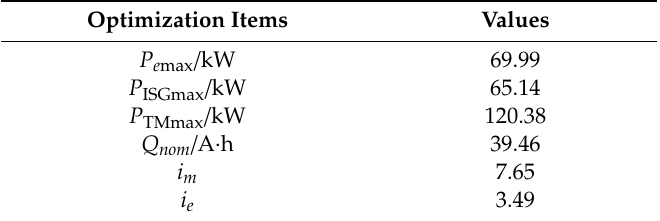
Table 4. Parameter optimization results.